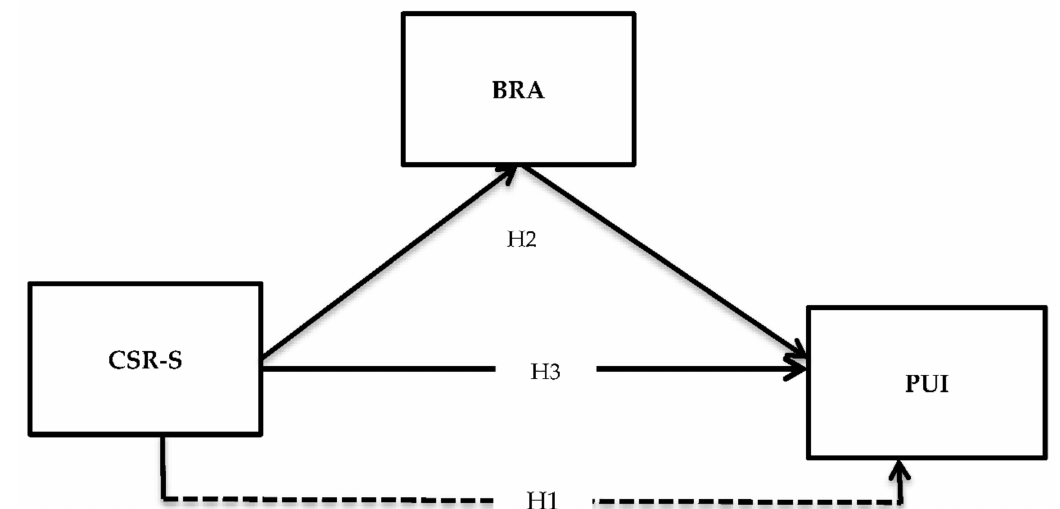
Figure 1. Proposed research model: This figure is based on the authors’ conception that contains three variables. There is the independent variable, CSR-S at the extreme left side, and at the extreme right side of the figure, there is the dependent variable PUI. In the middle of the figure, there is the mediating variable